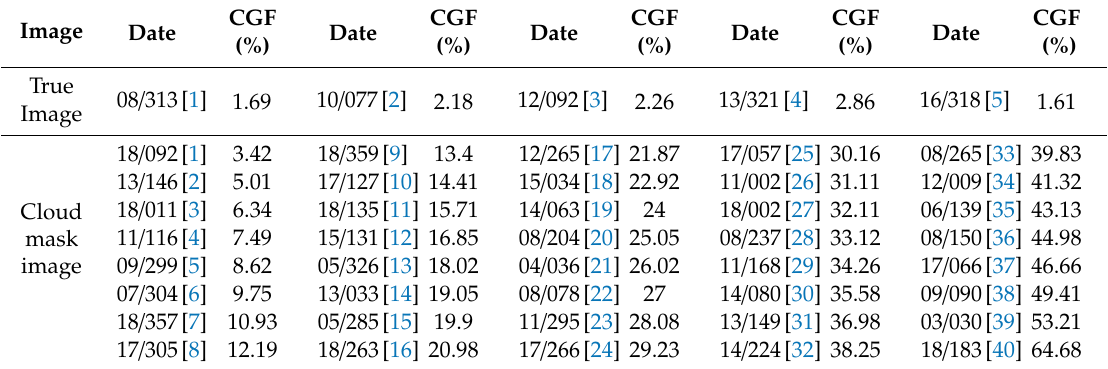
Table 4. Date and cloud-gap fraction information for true and cloud mask images.